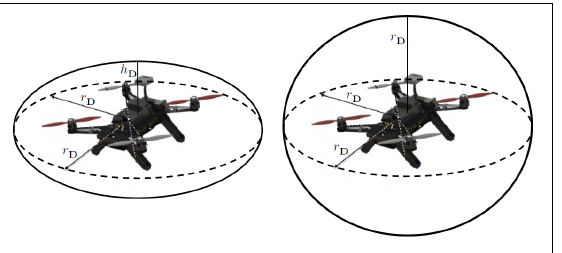
Figure 2. The quadrotor body can be represented as a sphere with radius r D ( right ), or an ellipsoid aligned with the axes of the body frame ( left ). Approximating the drone body with an ellipsoid allows considering the quadrotor’s rotational